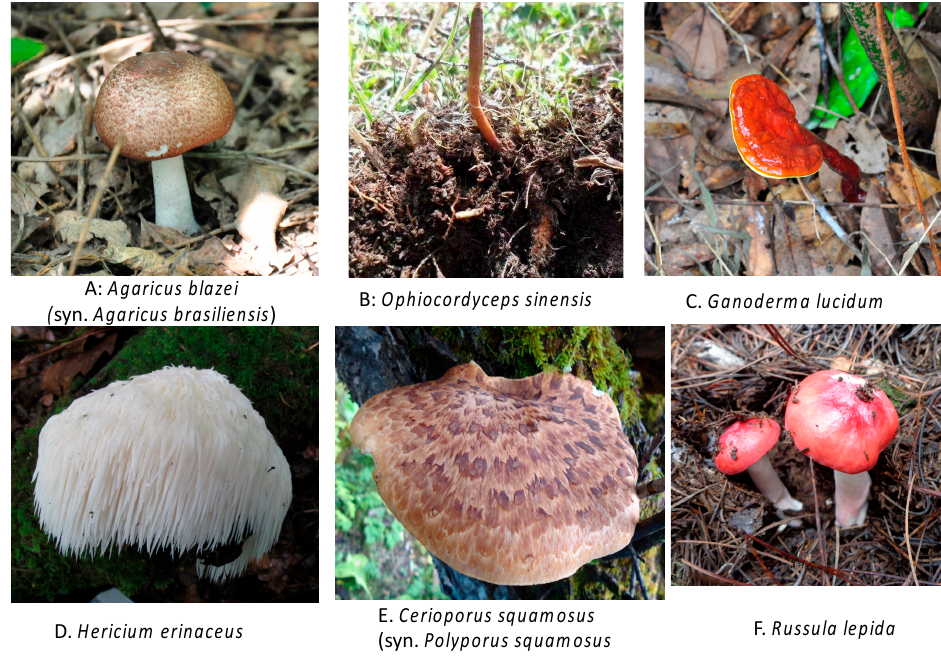
Figure 1. A few representative medicinal mushrooms from the wild.